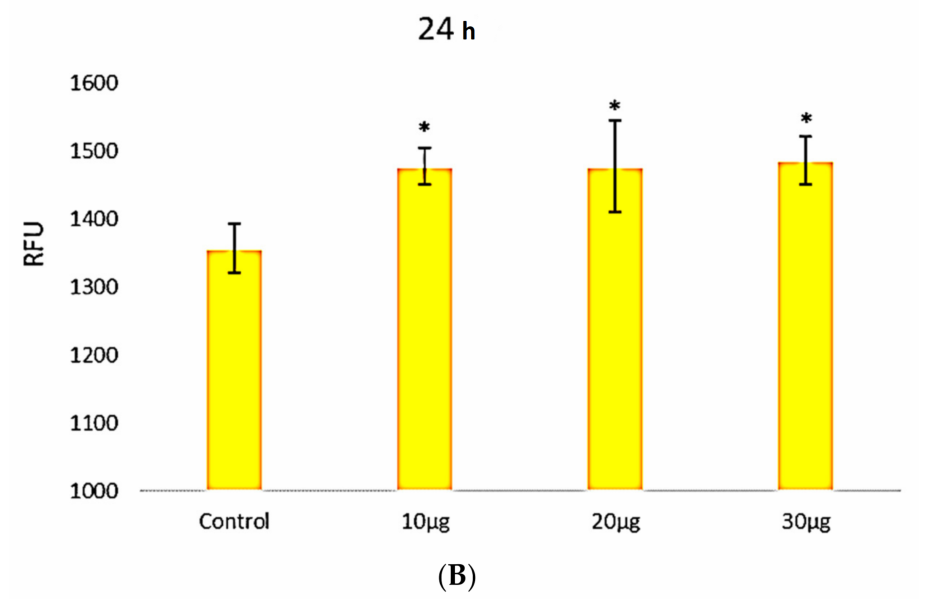
Figure 3. Effects of acetyl-xylogalactan on phagocytotic activity of THK macrophages. ( A ) THK cells treated with acetyl-xylogalactan for 12 h; ( B ) THK cells treated with acetyl-xylogalactan for 24 h. * p < 0.05. All treatment groups were compared to the control